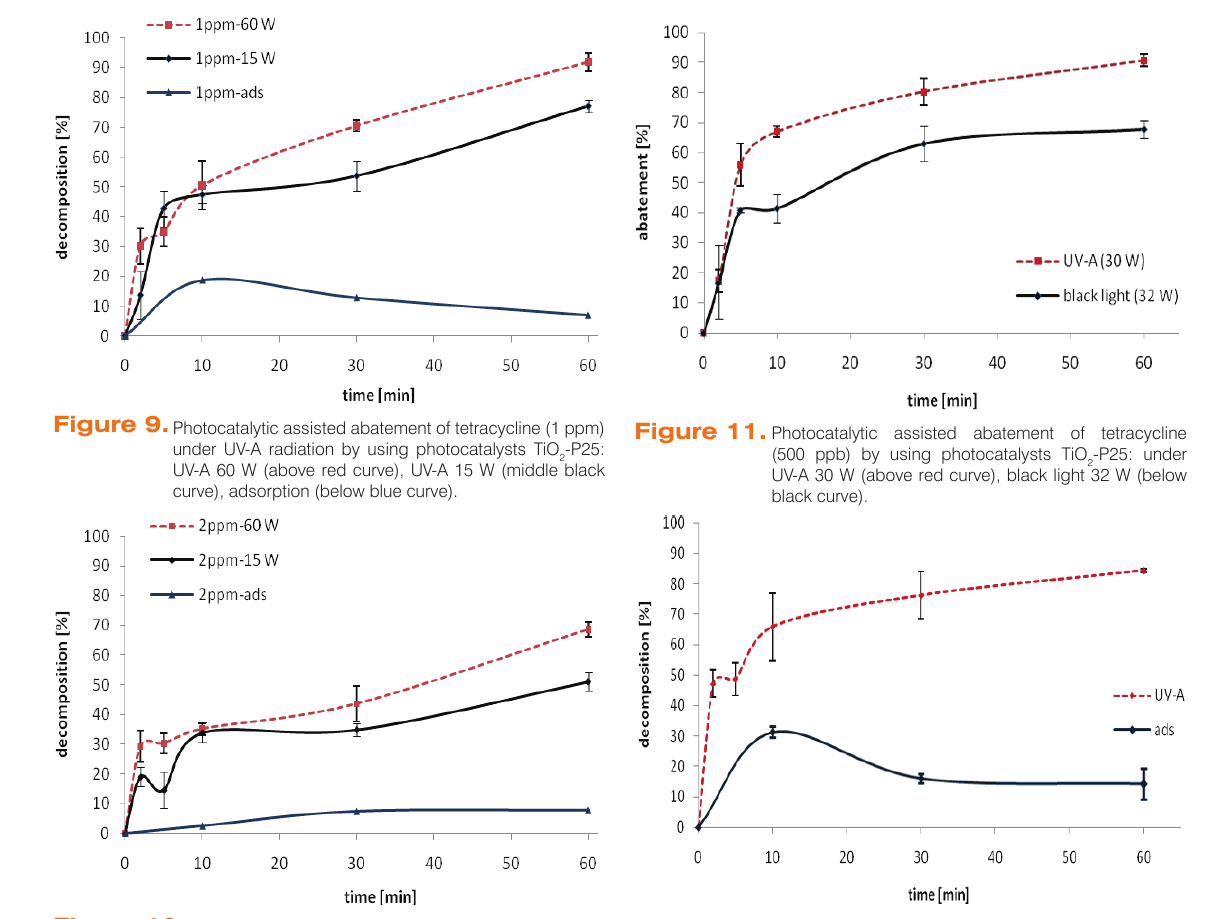
Figure 10. Photocatalytic assisted abatement of tetracycline (2 ppm) under UV-A radiation by using photocatalysts -P25: UV-A 60 W (above red curve), UV-A 15 W TiO 2 (middle black curve), adsorption (below blue curve).